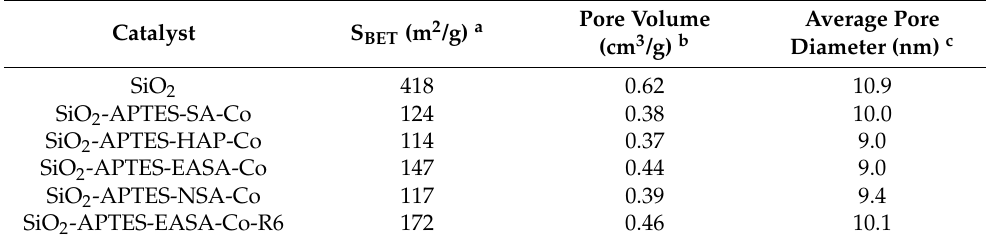
Table 2. Textural properties of the synthesized the fresh and spent SiO 2 -APTES-EASA-Co catalysts in comparison with the support SiO 2 .